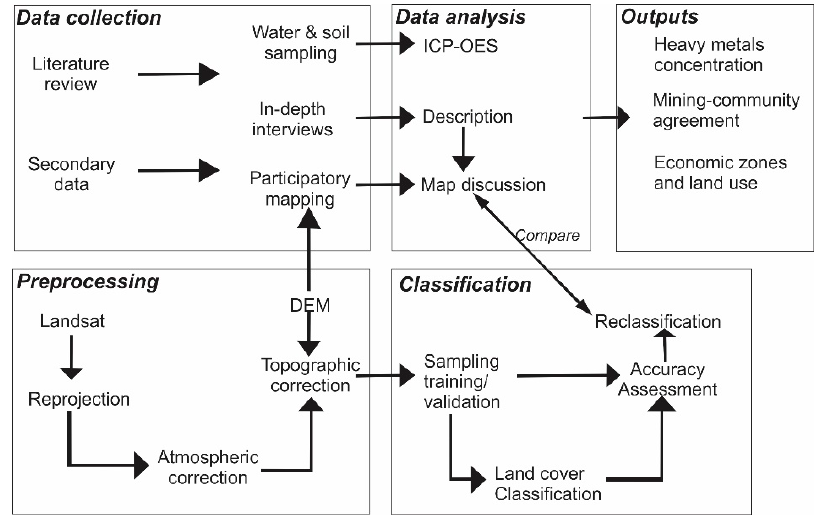
Figure 1. Overview of the research methodology (based on [50,55,56]).